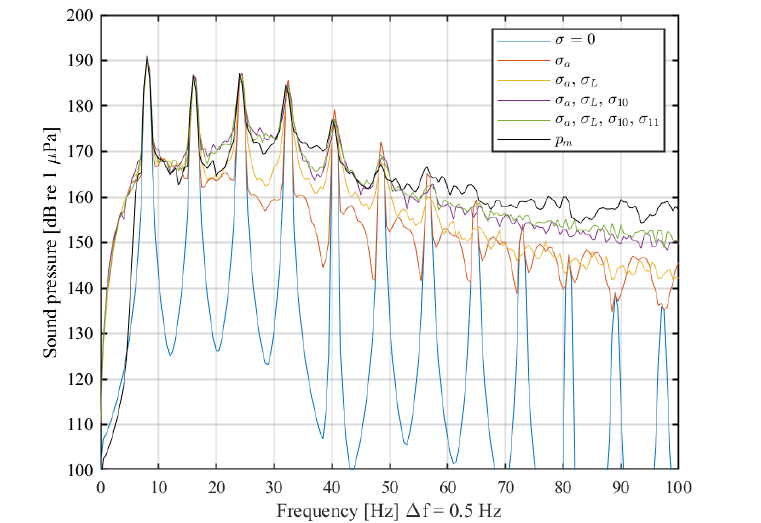
Figure 14. Sound pressure spectra of artificial signals generated by variation of all four shape parameters taking effect successively based on standard deviations evaluated from the measured blade passages as stated in Table 3 for 96.5 rpm in comparison to the unvaried signal (blue) and the measured signal p m